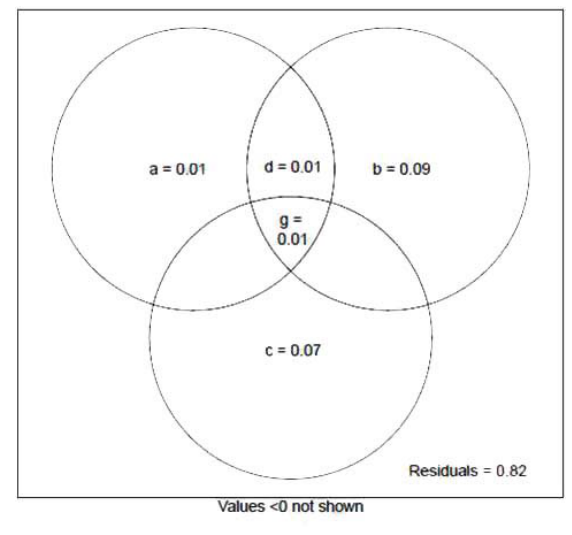
Fig. 5 . Partitioned variance between supercanopy and medium/large pine (a); age, basal area of conifers, and basal area of deciduous trees (b); and landscape metrics (c). (d) = variance shared between (a) and (b); g = variance shared between (a), (b), and (c). Residuals = 0.82 is unexplained variance. Values show proportion of